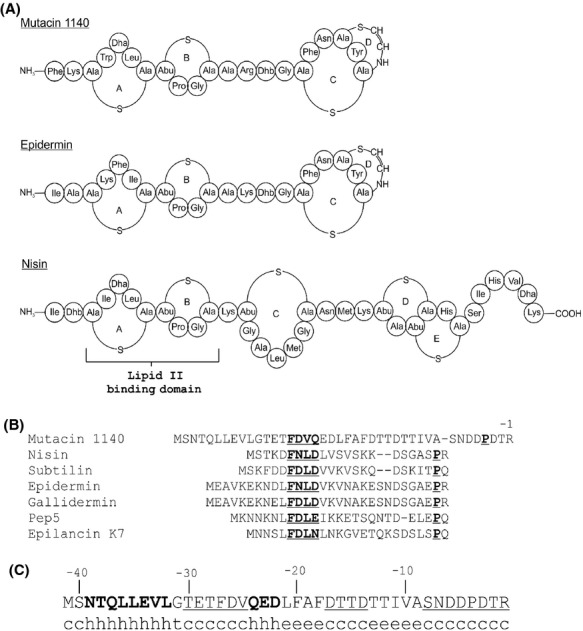
Lantibiotic structural elements. (A) Covalent structures for mutacin 1140, epidermin, and nisin with the lanthionine rings labeled from N- to C-terminus. (B) Leader sequence alignments of structurally related class I type AI lantibiotics; that is, mutacin 1140 produced by Streptococcus mutans, nisin produced by Lactococcus lactis, subtilin produced by Bacillus subtilis, epidermin produced by Staphylococcus epidermidis, gallidermin produced by Staphylococcus gallinarium, Pep5 produced by Staphylococcus epidermidis, epilancin K7 produced by Staphylococcus epidermidis (Gross and Morell 1971; Allgaier et al. 1986; Kellner et al. 1988; Kaletta et al. 1989; Piard et al. 1992; Klein and Entian 1994; Vandekamp et al. 1995; Hillman et al. 1998). (C) Secondary structure prediction using SOPMA for mutacin 1140 leader peptide; h (alpha helix), e (extended strand), c (random coil), t (beta turn). Alpha helical regions are in bold, while random coils are underlined in the leader peptide sequence.